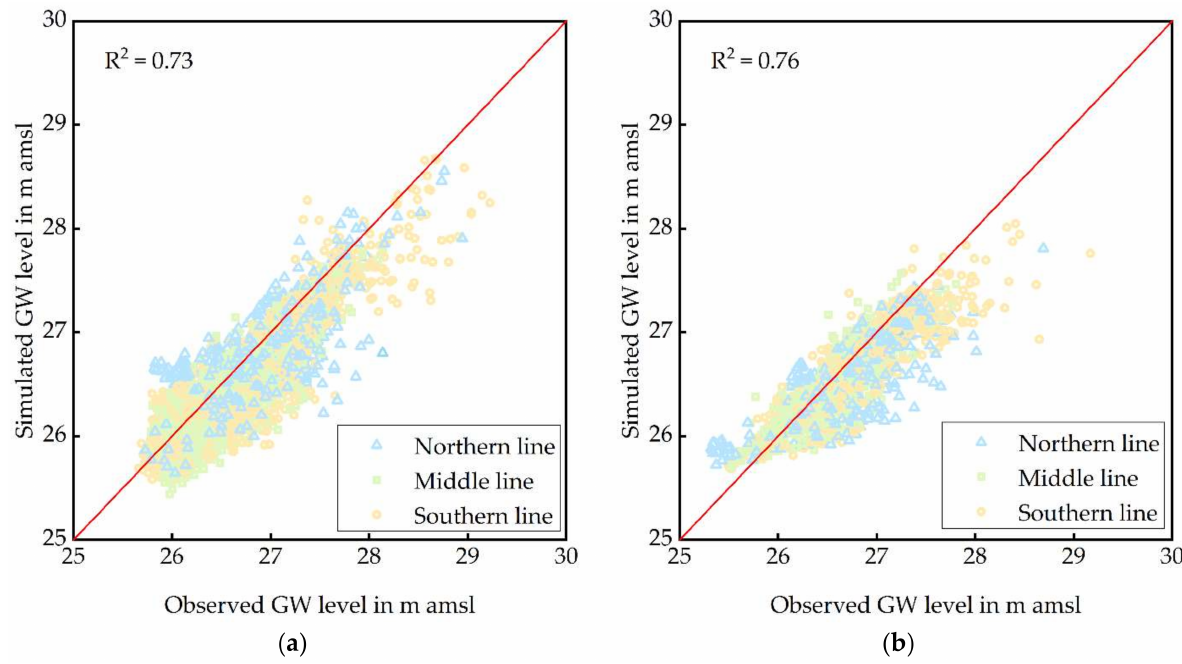
Figure 3. Comparison of the groundwater levels in the study area during the calibration